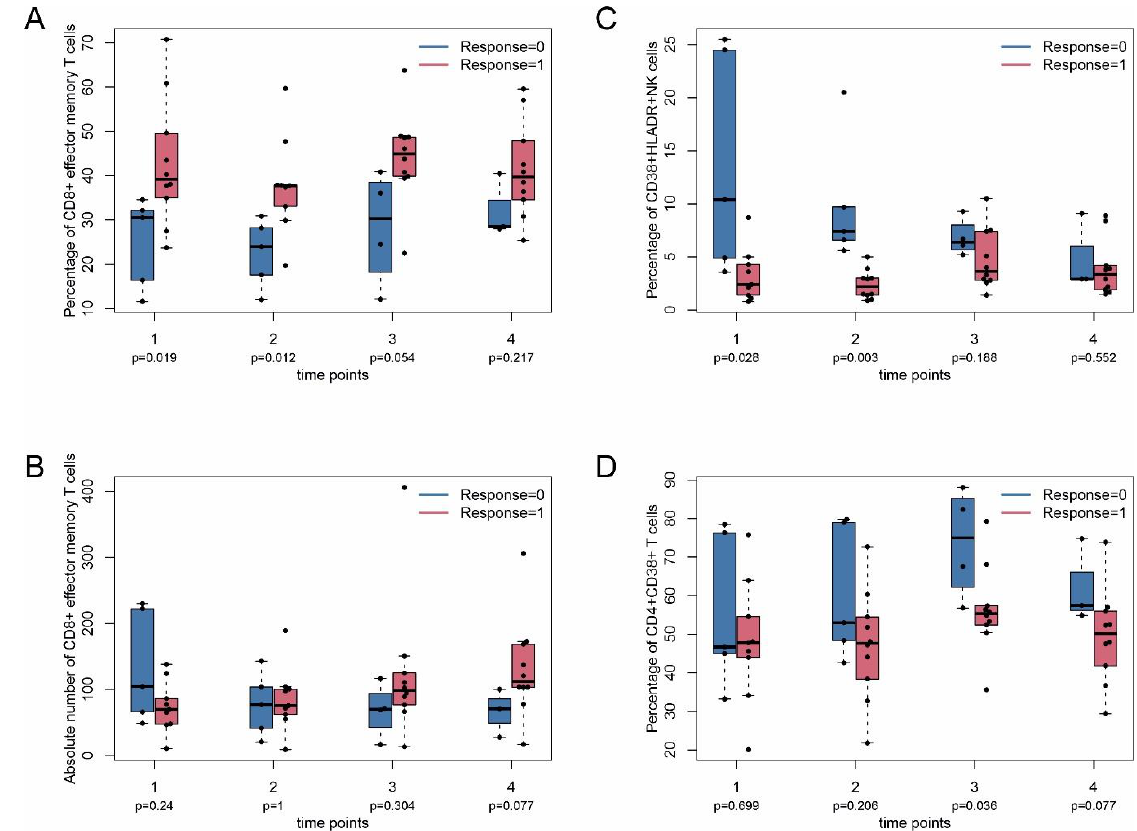
Figure 3. Inflammatory T cell subpopulations in ICI responders and non-responders. PBMC were taken from patients at indicated time points as described in Figure 1 and analyzed by flow cytometry (FACS). ( A , B ) Percentage and absolute number of effector memory T cells, respectively. ( C ) CD38 + HLADR + NK cells. ( D ) CD4 + CD38 + cells. Nominal (unadjusted) p -values (Mann–Whitney U test between responders and non-responders) are shown without adjustment for multiple testing. Responders are indicated by response = 1, non-responders by response = 0. Data in ( A ) are given as percentage of CD8 + effector memory cells of total CD8 + T cells. Absolute number refers to CD8 + effector memory cells per μL. Data in ( C ) are given as CD38 + HLADR + cells of total NK cells. Data in ( D ) are given as percentage of CD38 + cells of total CD4 + cells.